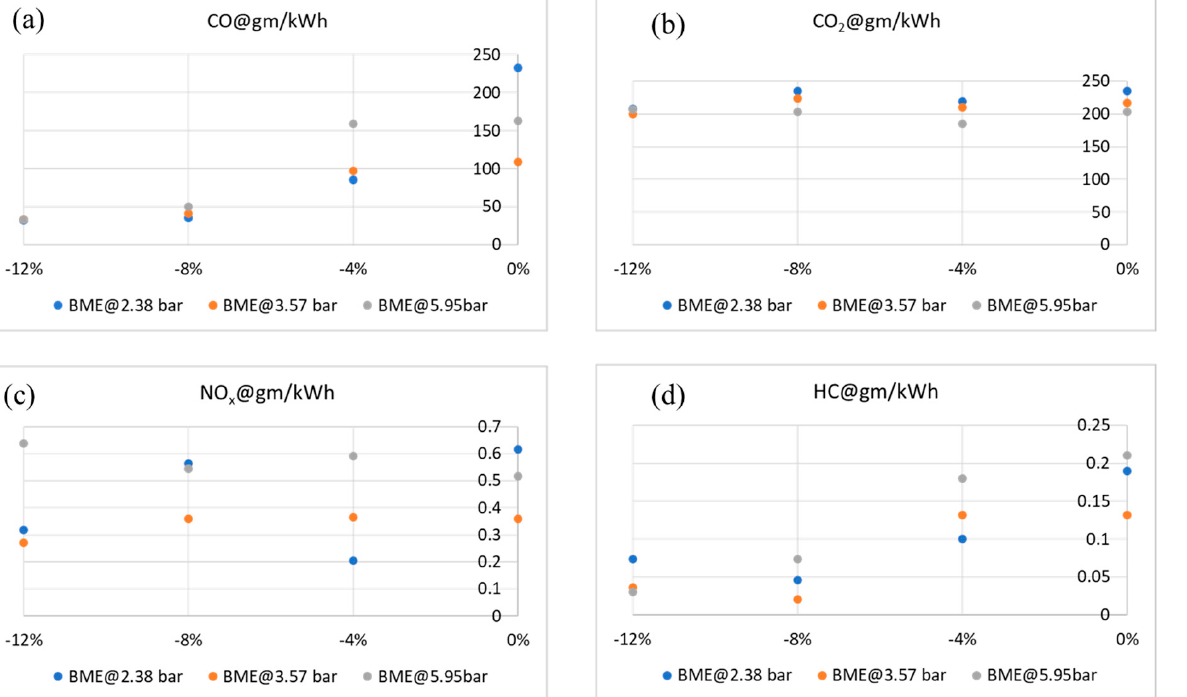
9 of 26 Figure 3. Fuel carbon redundancy effect on fuel characteristics: ( a )calorific value(kJ/kg); ( b )blend